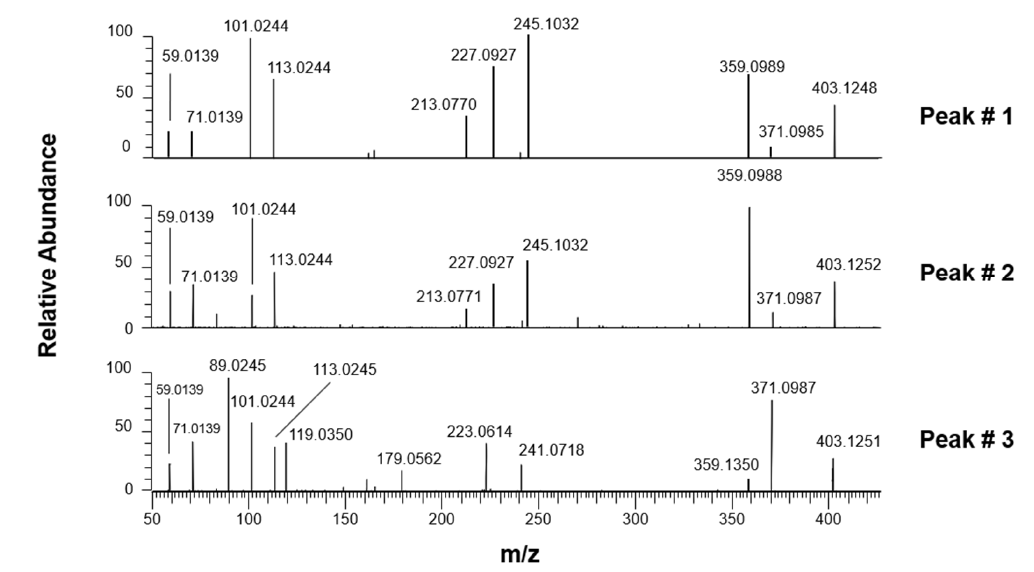
Figure 6. HCD-MS/MS spectra averaged under peaks numbered as #1–#3 in the XIC traces referred to elenolic acid glucoside/secoxyloganin after the RPLC-ESI(-)-FTMS analysis of Coratina leaves extracts.